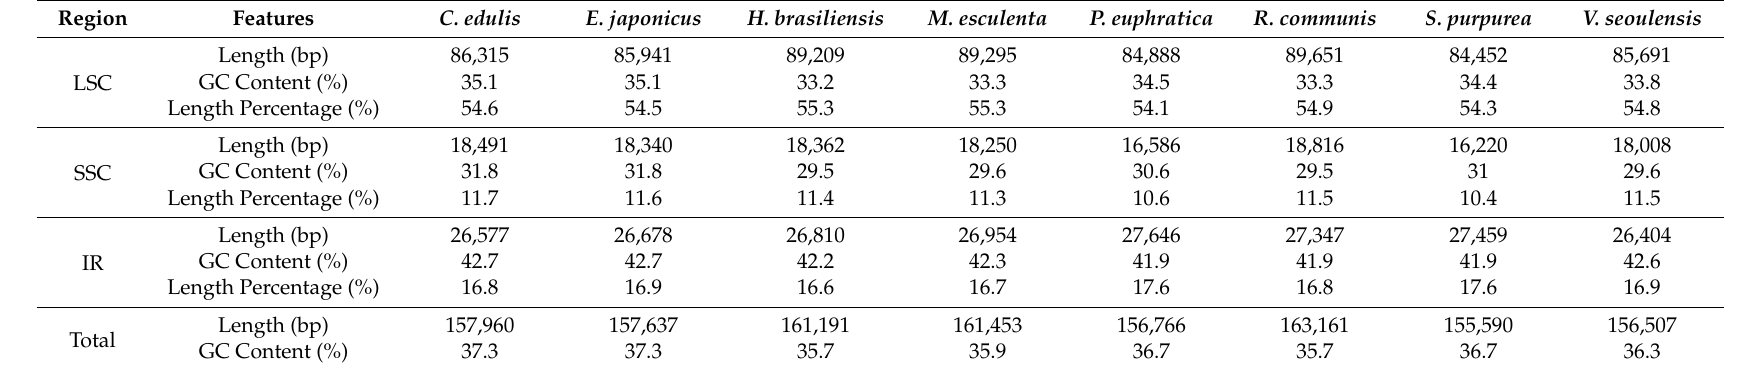
Table 1. Comparison of plastid genome size among eight species.